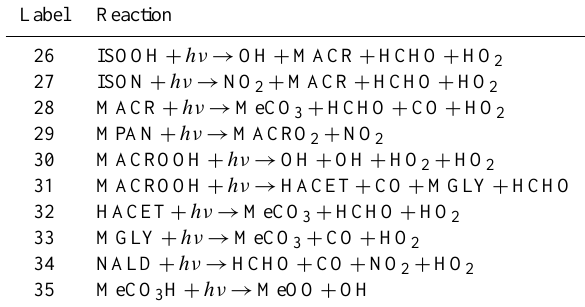
Table 8. Additional photolytic reactions associated with the Mainz Isoprene Mechanism in the UKCA TropIsop chemistry scheme, where IS = C 5 H 7 , ISON = lumped peroxy alkyl nitrates (from C 5 H 8 +NO 3 ) and hydroxy alkyl nitrates (from ISO 2 + NO), MACR = lumped species consisting of methacrolein, methyl vinyl ketone and other C 4 carbonyls from isoprene chemistry, MPAN = peroxy methacrylic nitric anhydride (and other higher PANs from isoprene chemistry), HACET = hydroxyacetone and other C 3 ketones, MGLY = methylglyoxal nd other C 3 carbonyls, and NALD = nitrooxy